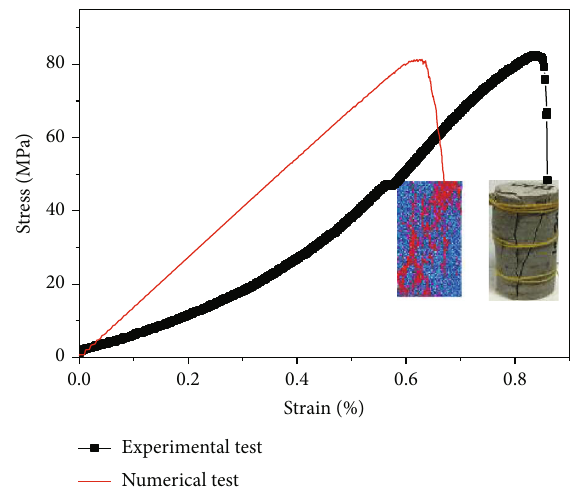
Figure 1: Stress-strain curves of sandstone based on experimental and numerical tests